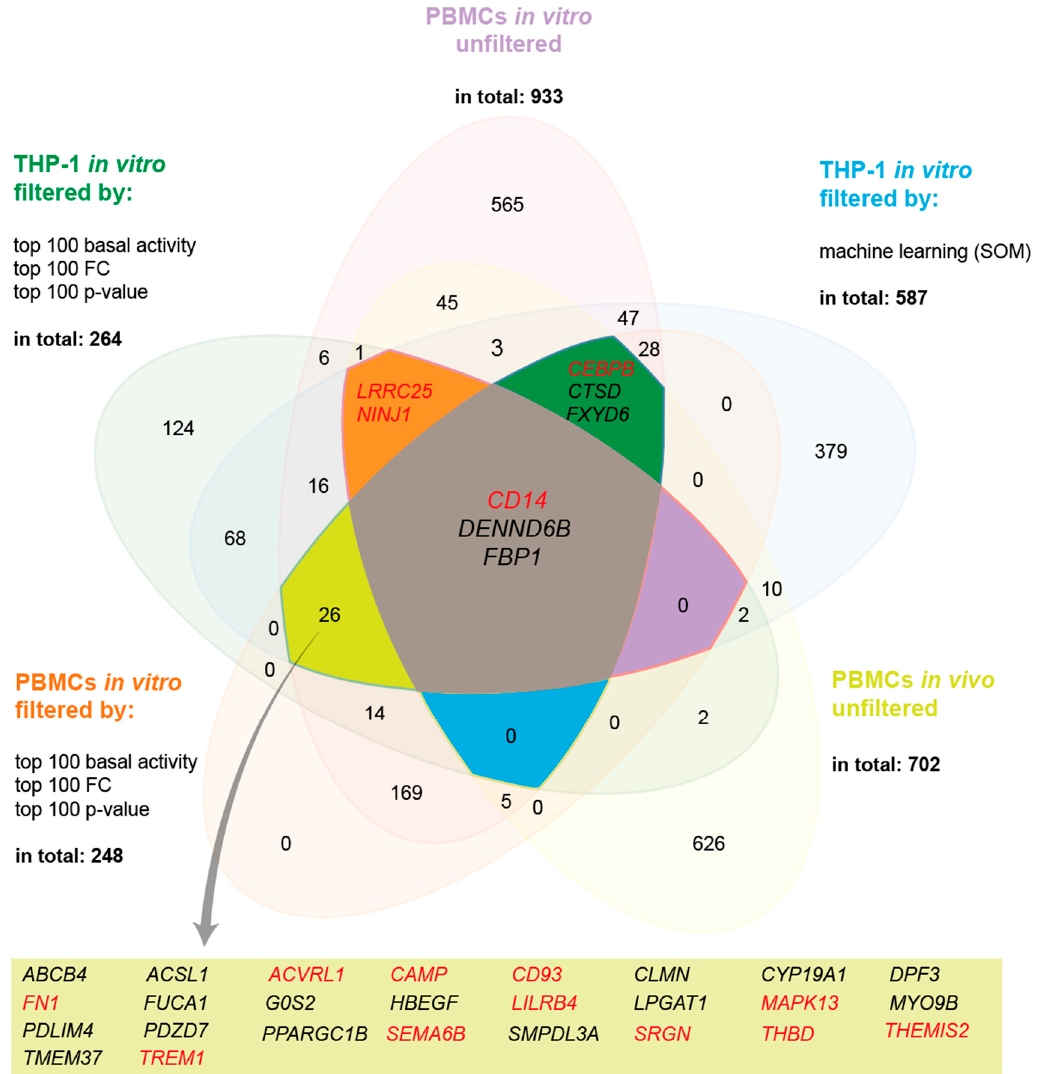
Figure 1. Key vitamin D target genes in immune-related cell types. A Venn diagram represents vitamin D target genes that are common in THP-1 cells stimulated in vitro in three biological repeats